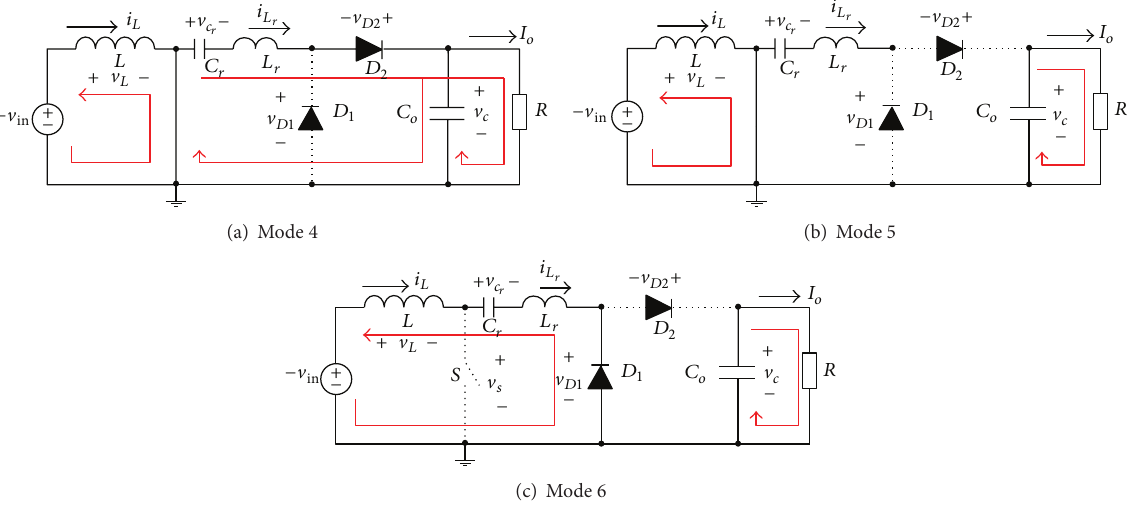
Figure 4: Equivalent circuit of operation mode of the converter with negative input voltage.